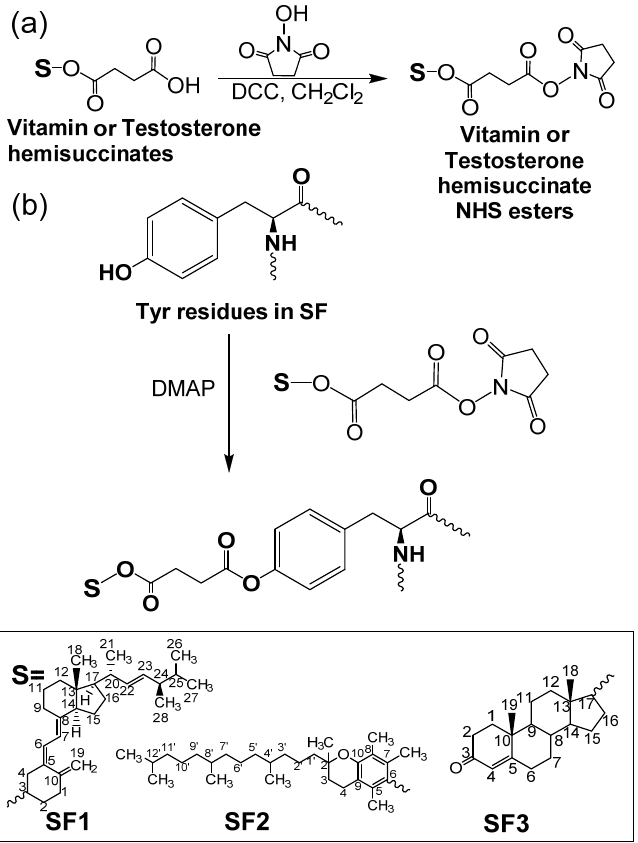
Figure 1. Synthetic route to vitamins–SF and testosterone–SF. ( a ) Formation of N -hydroxysuccinimide derivatives of vitamin and testosterone hemisuccinate; ( b ) reaction of tyrosine moieties in SF with vitamin and testosterone N -hydroxysuccinimide derivatives. Table 1. Degree of substitution (DS %) and yield (Y %) of synthesized SF derivatives. Num- ber average molecular weight (M n ) of raw SF.